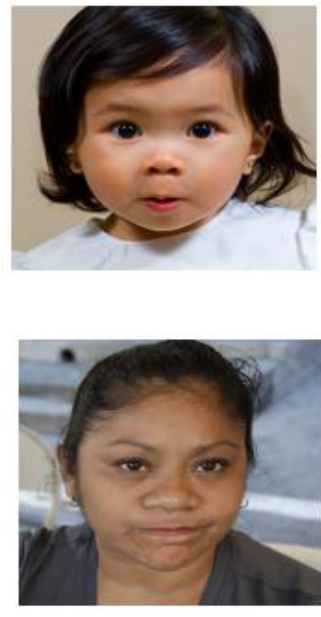
Figure 6. Sample images from the DFDC dataset.